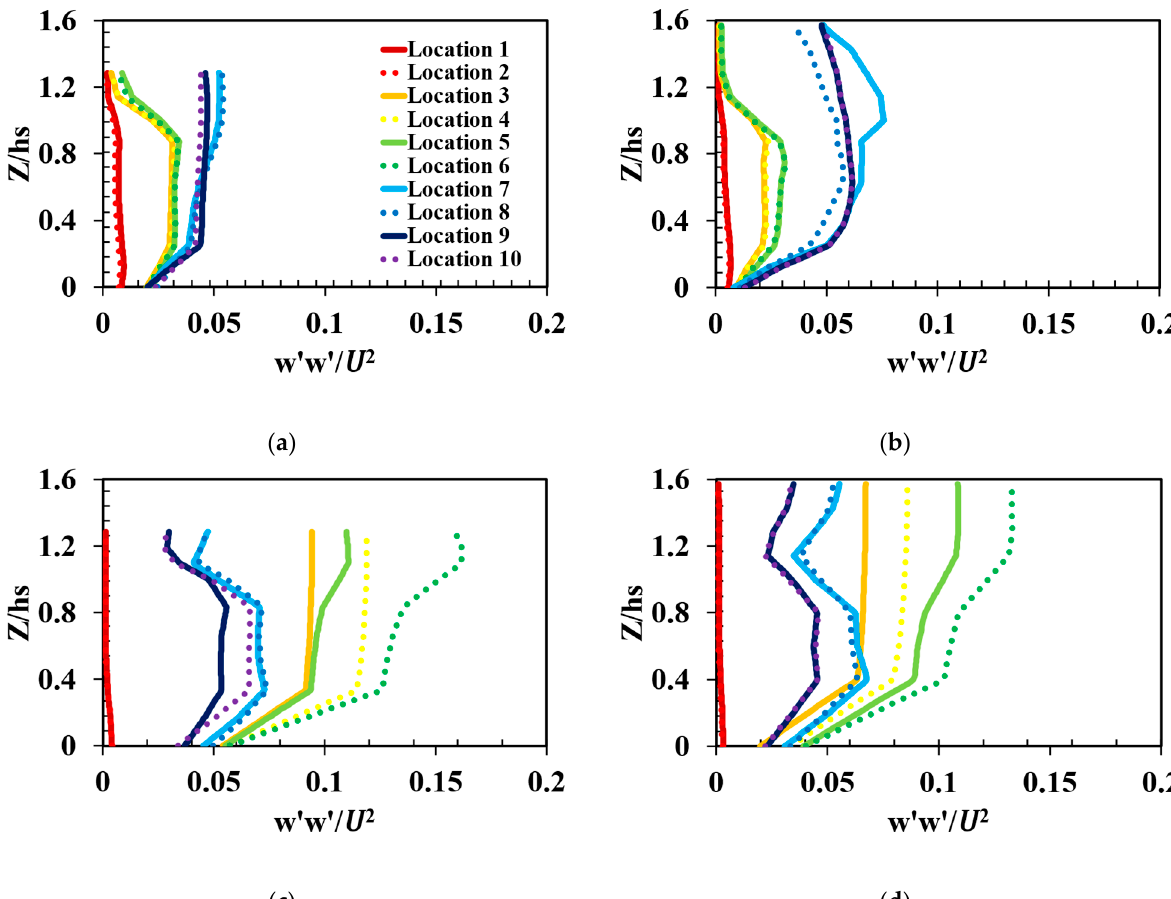
Figure 10. ( a – d ) The vertical profiles of normal stresses ( w’w’ ) at specified locations: ( a ) case 1; ( b